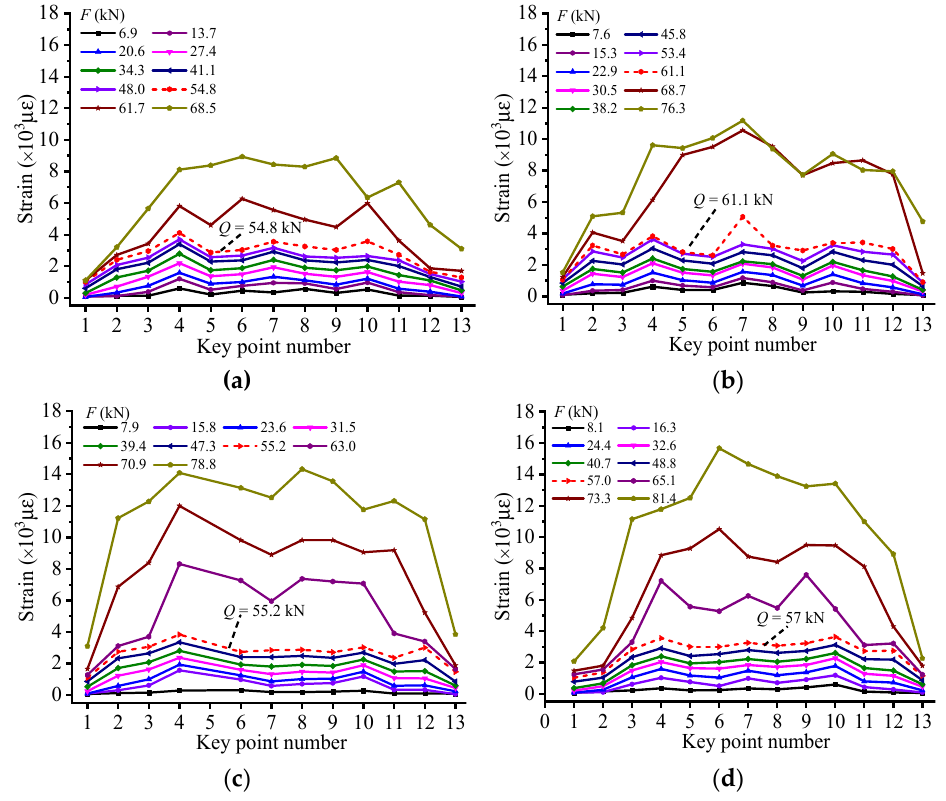
Figure 9. The strain distribution pattern of CFRP for ( a ) EG-2-0, ( b ) EG-2-10, ( c ) EG-2-16, and ( d ) EG-2-20.